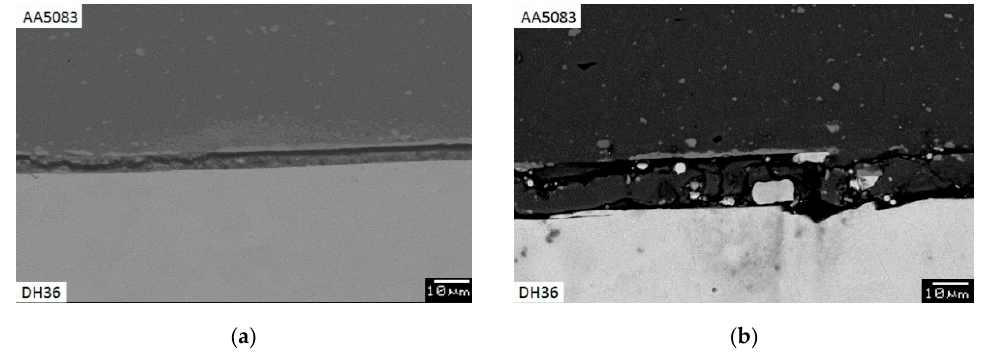
Figure 17. Scanning electron microscopy (SEM) images for the deposition interface: ( a ) central region and ( b ) retreating side. and ( b ) retreating